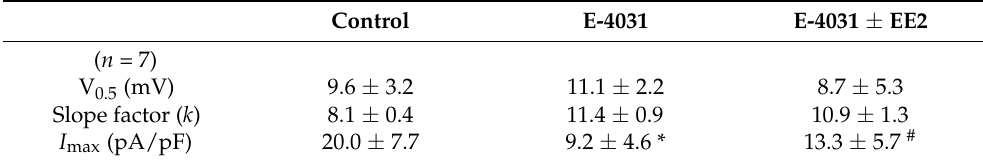
Figure 4. Effects of EE2 on I–V relationships of hERG currents by E-4031. I–V relationships of the hERG channel were activated by the same voltage protocol described in Figure 1D, and compared before drug application (control, black), after 30 nM E-4031 block (blue), and after the addition of EE2 (30 nM E-4031 + 1 nM EE2, green). ( A ), Representative traces elicited by step pulses ( − 40 mV to 60 mV). Tail peaks are indicated by arrows. Scale, 20 pA/pF, 1 s. ( B ), Tail I-V curves before (control), after the application of E-4031, and after the addition of EE2 (E-4031 + EE2). p < 0.05 ANOVA with repeated measures. * p < 0.05 vs. control. ( C ), Respective tail peak amplitudes were normalized to the tail amplitude preceding 60 mV before drug applications (control). p < 0.05 ANOVA with repeated measures. * p < 0.05, ** p < 0.01, vs. control, # p < 0.05 vs. E-4031. ( D ), Comparison of channel availability curves obtained from tail I-Vs. Smooth lines are Boltzmann fits, as described in the Methods, that generated V0.5 of activation in Control (black line), in E-4031 (blue line), and in E-4031/EE2 (green line); ns, ANOVA. Seven experiments were performed. Significance was evaluated using Student’s t-tests after repeated measures one-way ANOVA. Table 2. Effects of EE2 at 1 nM on the change in voltage dependence of the hERG activation by E-4031 at 30 nM. The experimental condition and results are also shown in Figure 4. Seven experiments were